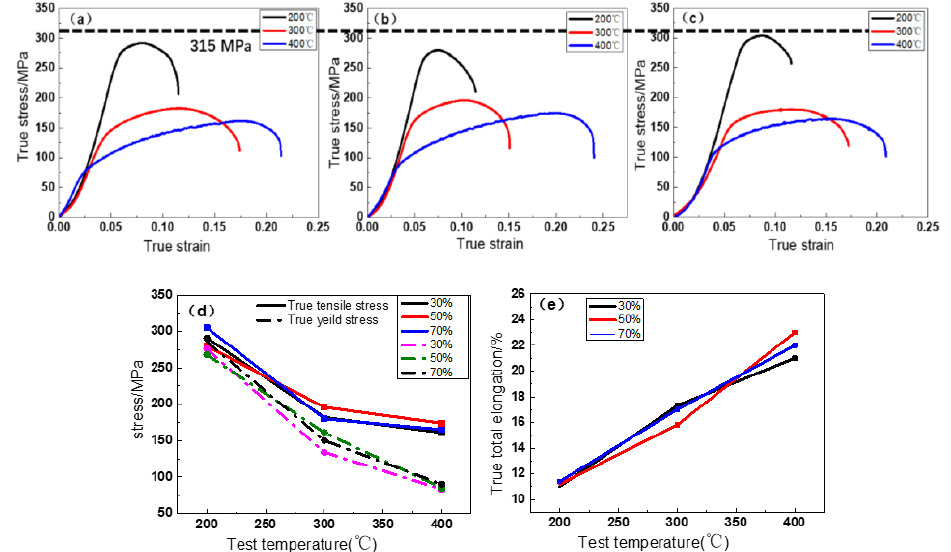
Figure 3. Tensile true stress–strain curves of samples with different deformation degrees: ( a ) 30%; ( b ) 50%; ( c ) 70%; ( d ) true tensile/yield stress; ( e ) true total elongation.